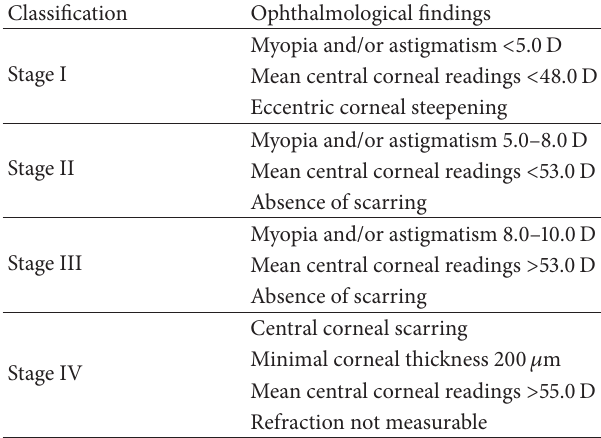
Table 1: Typical connective tissue disorders with ocular, auditory, musculoskeletal and cutaneous features in brittle cornea syndrome (modified from [1]).